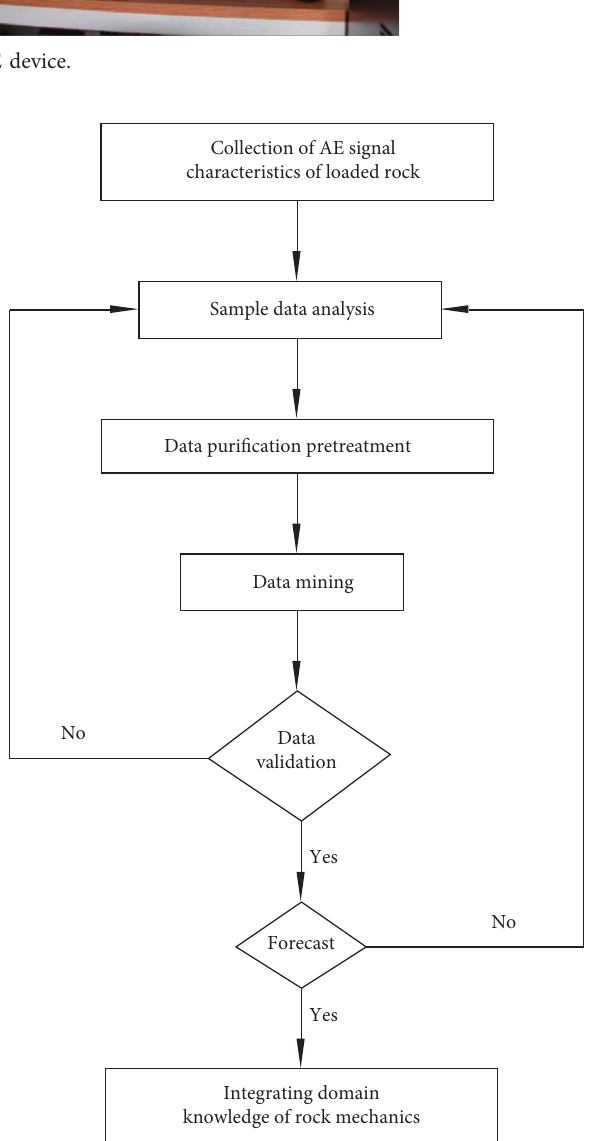
Figure 5: Detailed technical route of data